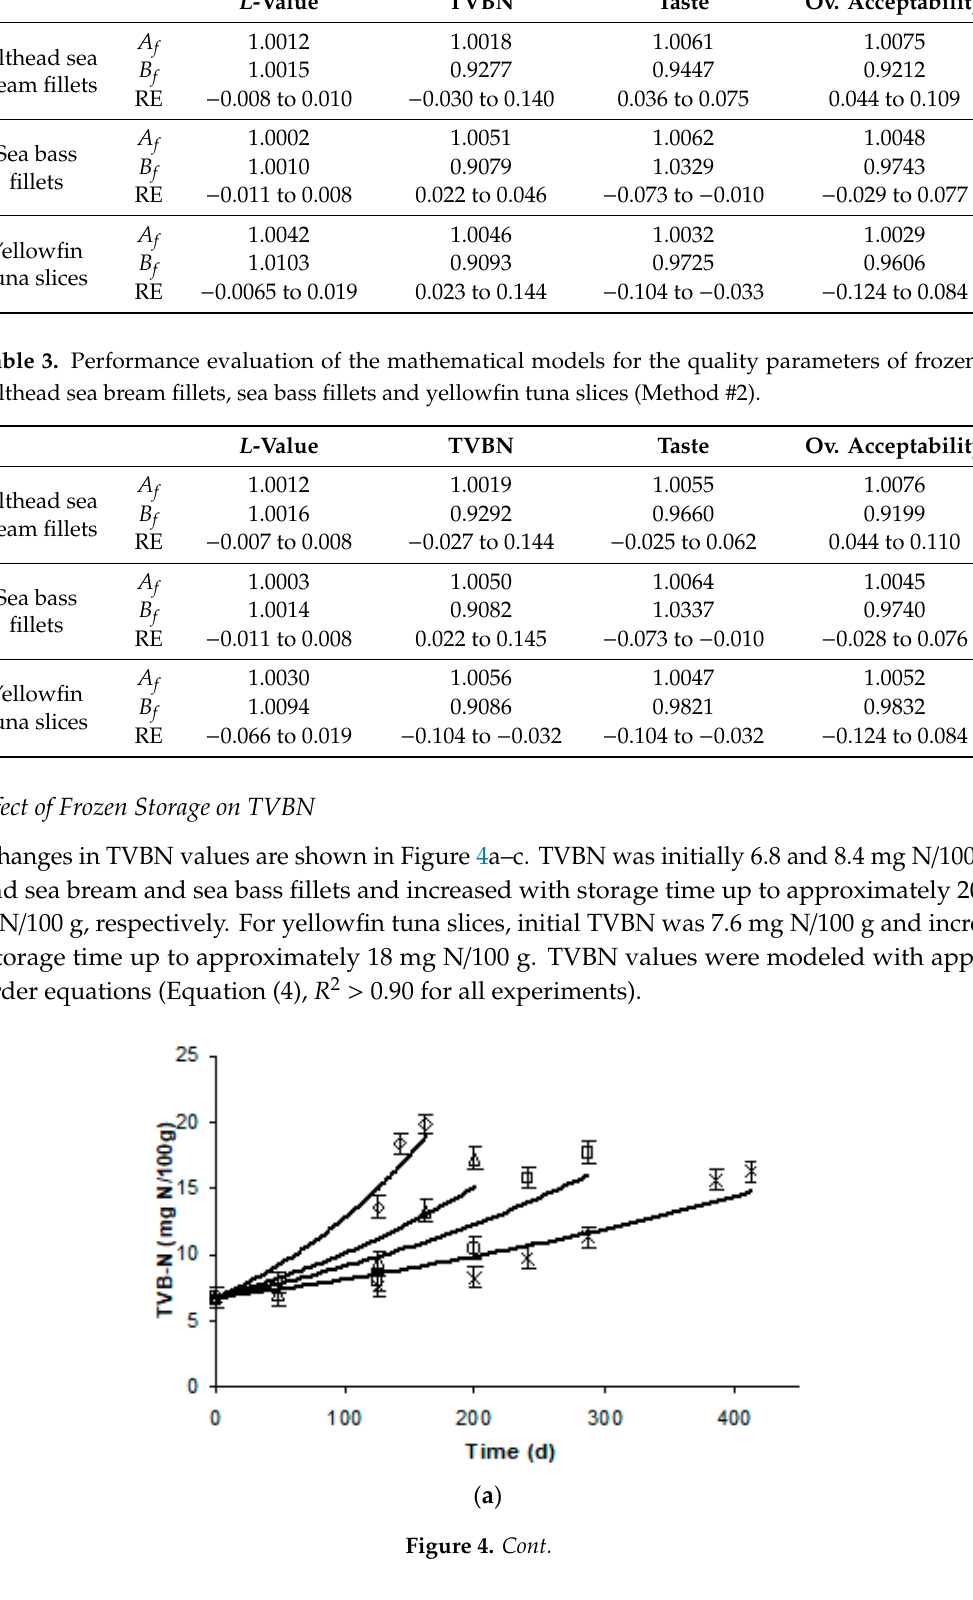
Table 2. Performance evaluation of the mathematical models for the quality parameters of frozen